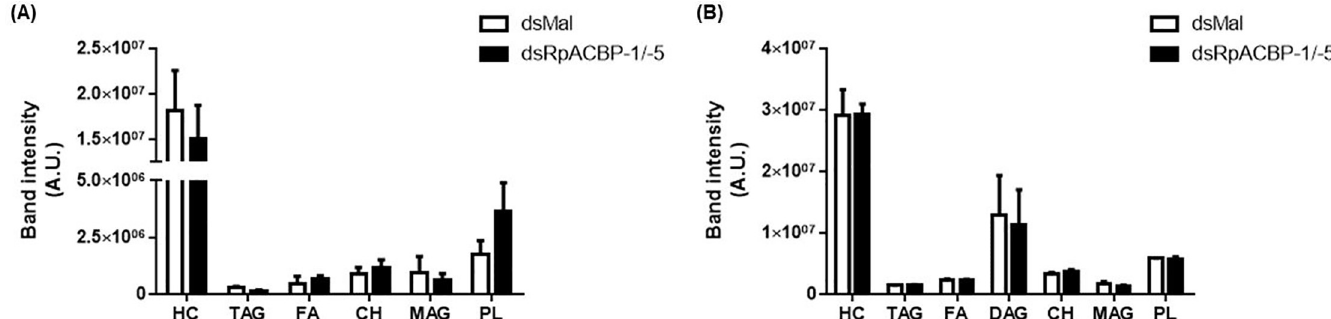
Fig 10. RpACBP-1 / RpACBP-5 double knockdown does not affect posterior midgut or hemolymph lipid composition. Starved females were injected with a mixture of dsRNAs containing one μ g of dsACBP-1 plus one μ g of dsACBP-5 (dsRpACBP-1/5), or with two μ g of dsMal, used as a control. The insects were fed three days after the injection, and the posterior midgut (A) and hemolymph (B) were collected on the fourth day after feeding. Composition of total lipids was analyzed by HPTLC. p > 0.05 by Student’s t -test, n = 3. HC = hydrocarbons; TAG = triacylglycerol; FA = fatty acid; DAG = diacylglycerol; CH = cholesterol; MAG = monoacylglycerol; PL = phospholipids.